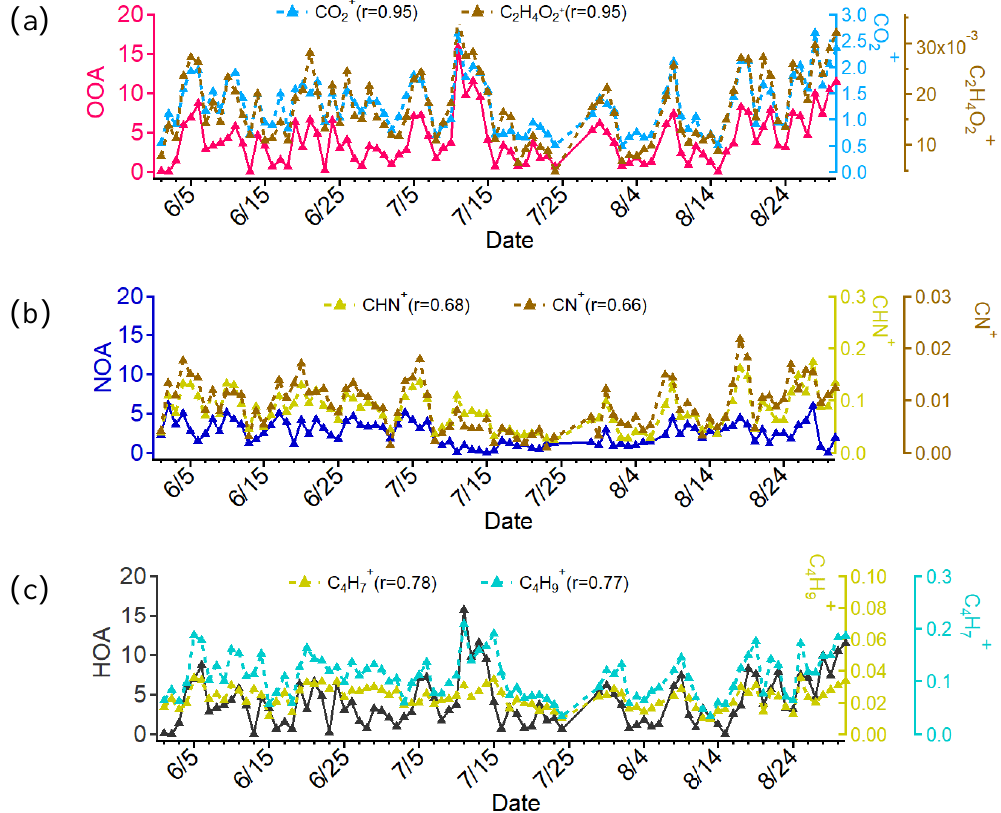
Figure 5. Correlation of resolved factors from PMF with special tracers in summer for ( a ) OOA, ( b ) NOA, and ( c ) HOA.